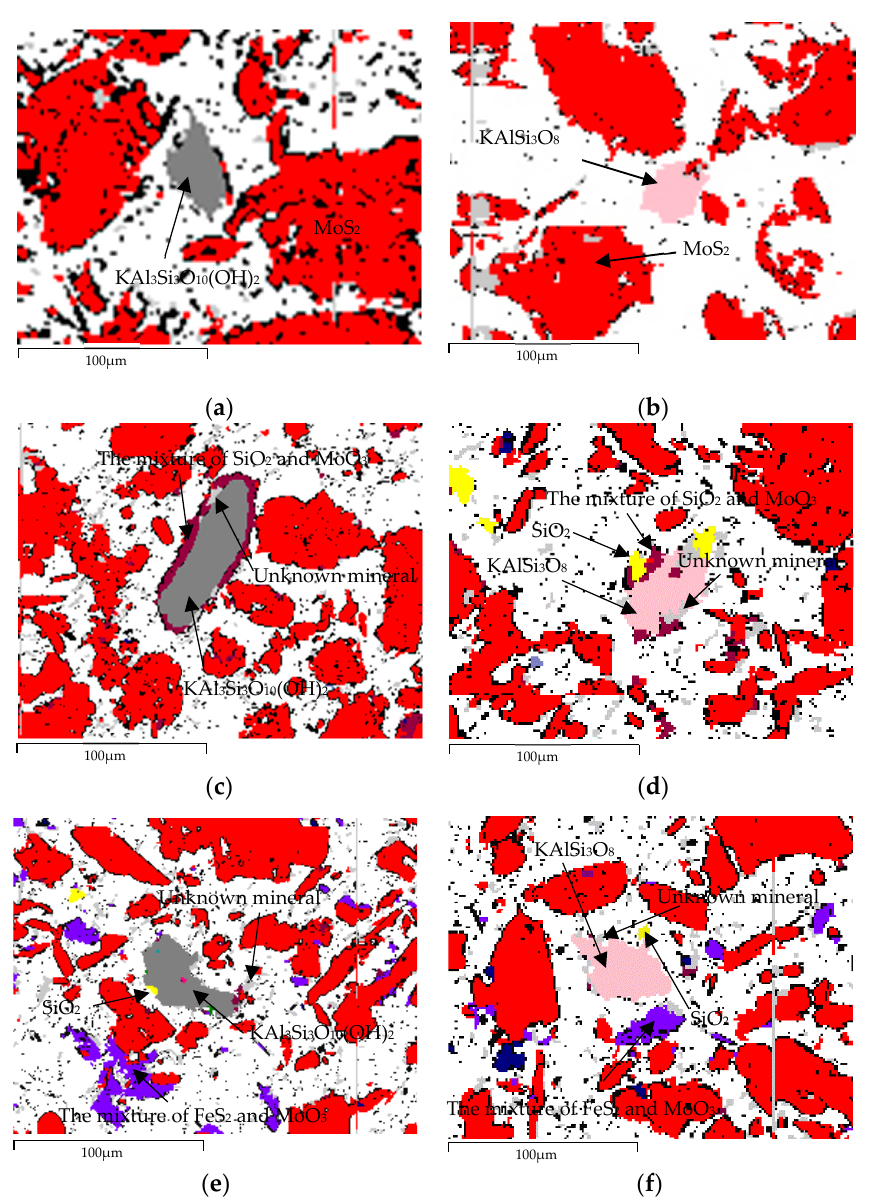
Figure 7. Enhanced backscattered electron microscope images of molybdenum concentrate, molybdenum calcine and washed molybdenum calcine. ( a ) Muscovite in molybdenum concentrate; ( b ) Orthoclase in molybdenum concentrate; ( c ) Muscovite in molybdenum calcine; ( d ) Orthoclase in molybdenum calcine; ( e ) Muscovite in washed molybdenum calcine ( f ) Orthoclase in washed molybdenum calcine.